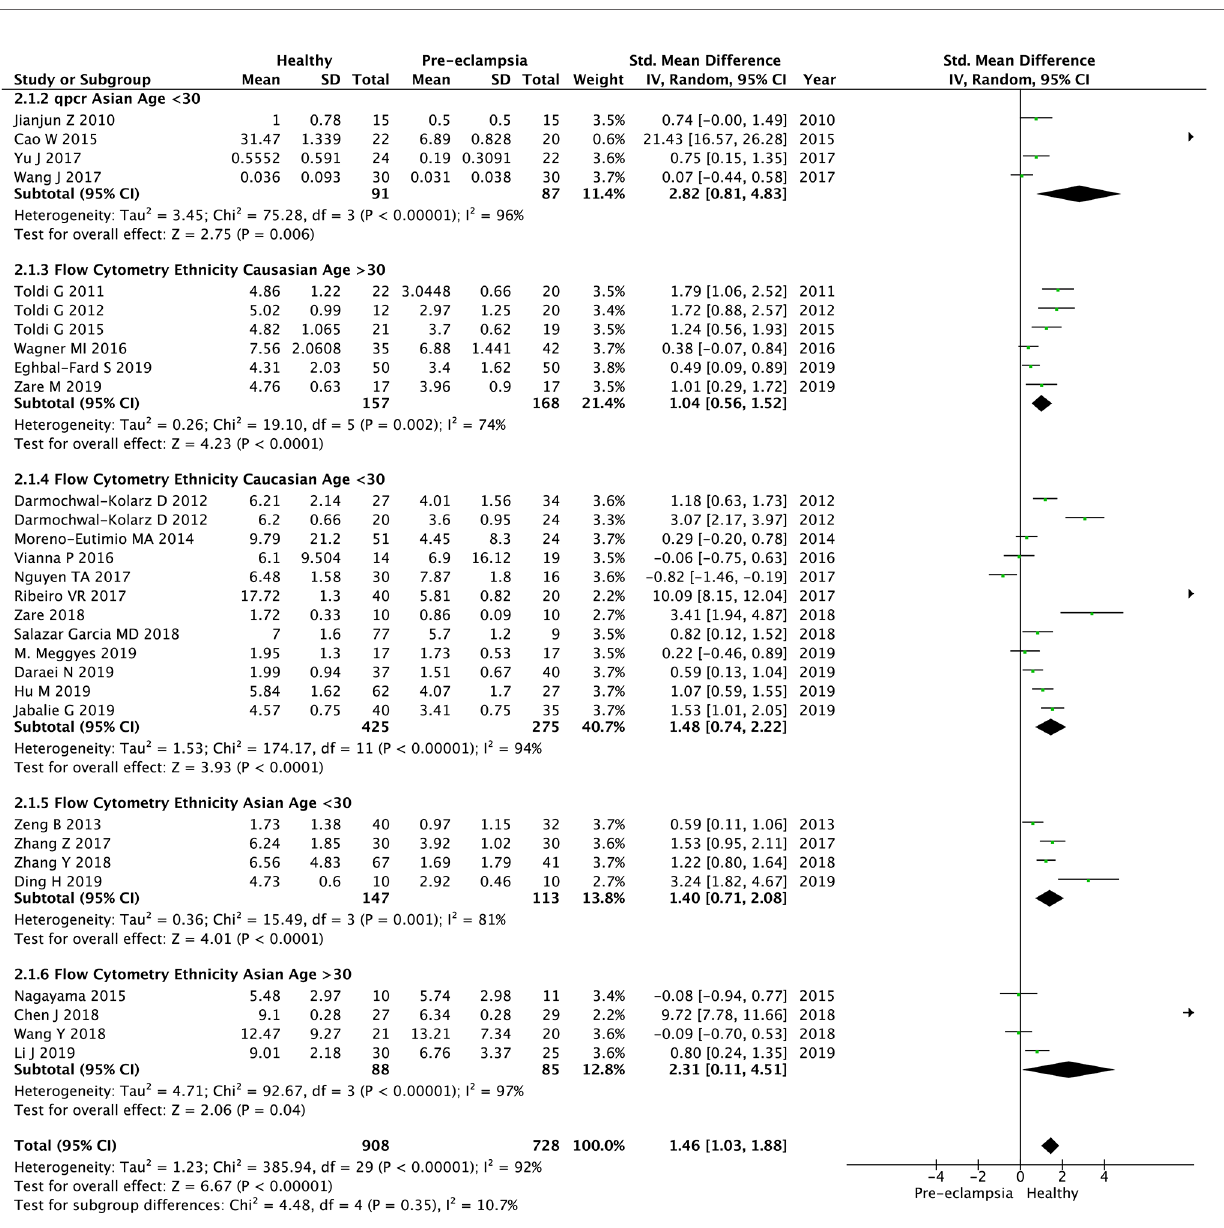
FIGURE 2 | Standardized mean difference of T regulatory cell numbers in the peripheral blood of healthy pregnant women and women with pre-eclampsia, in subgroups according to ethnicity, age and method of analysis. CI, con fi dence interval; SD, standard deviation; Std. Mean Difference, standardised mean difference; IV, inverse